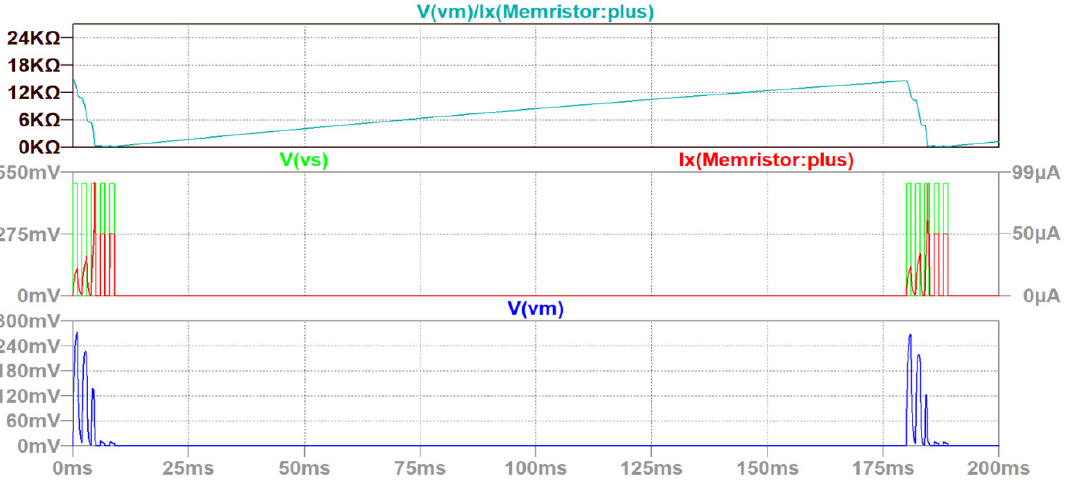
Figure 3. Simulated response of LIF circuit with volatile memristor on voltage pulse actuation: Memristance R M ( upper graph ), memristor’s current i M ( middle graph ) and the voltage across memristor v M ( bottom graph ). Table 2. Memristor’s subcircuit model parameters. R